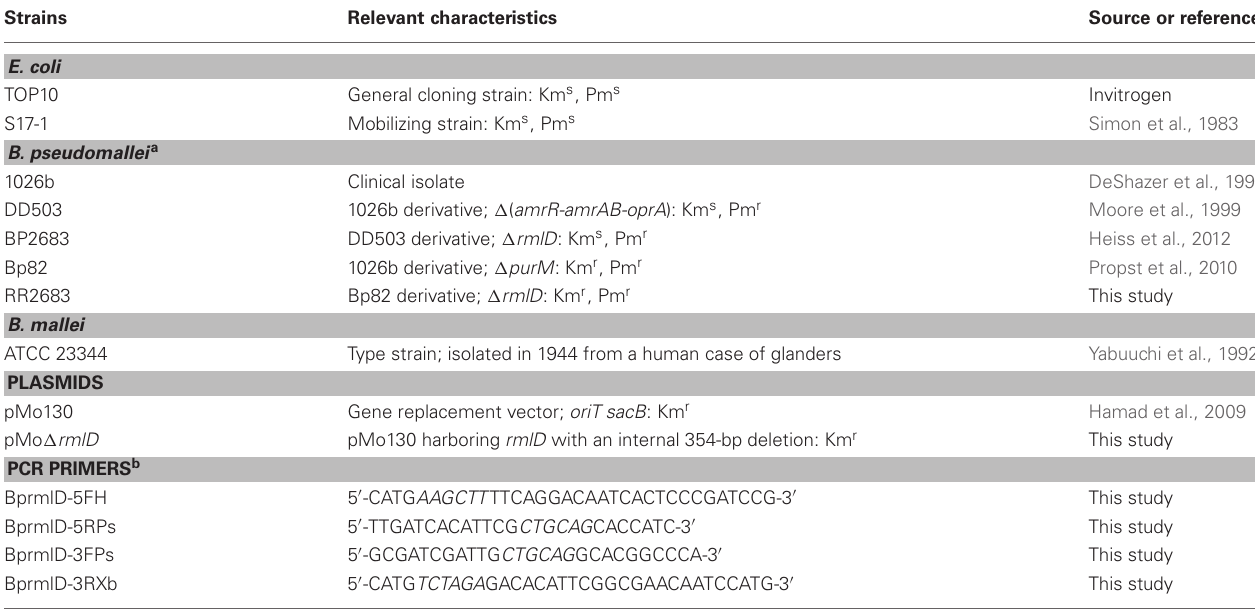
Table 1 | Strains, plasmids and